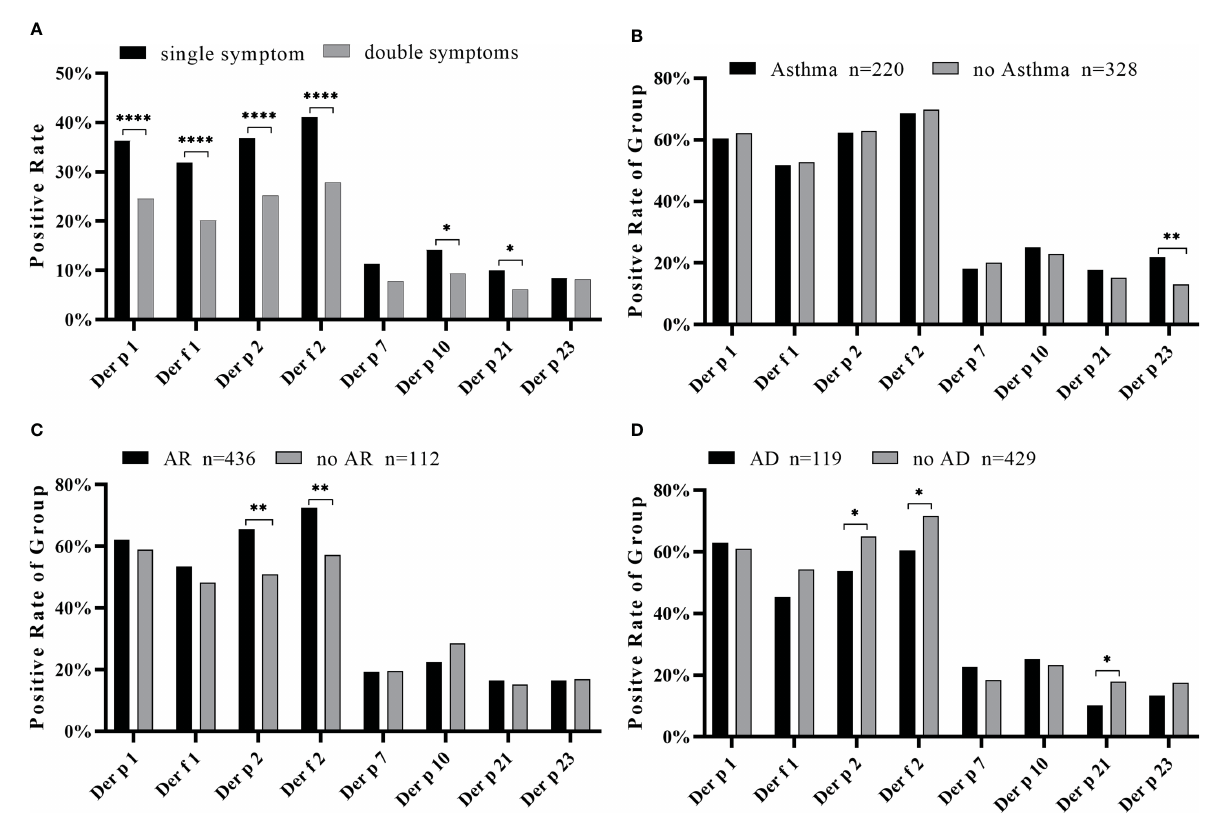
FIGURE 6 Positive rate of each component in simple or complex symptoms. (A) Positive rates of house dust mite component sIgE in one or two symptoms. The positive rate of component sIgE in the asthma group (B) , allergic rhinitis group (C) , and allergic skin disease group (D) . Compared by chi-square test, all data of positive rate of each group were analyzed. * p < 0.05; ** p < 0.01; **** p < 0.0001.